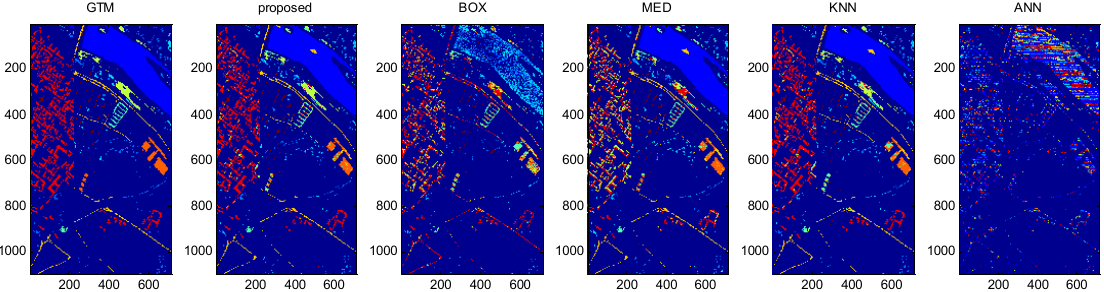
Figure 5. Ground Truth Map (GTM) and classification maps for university of Pavia Image